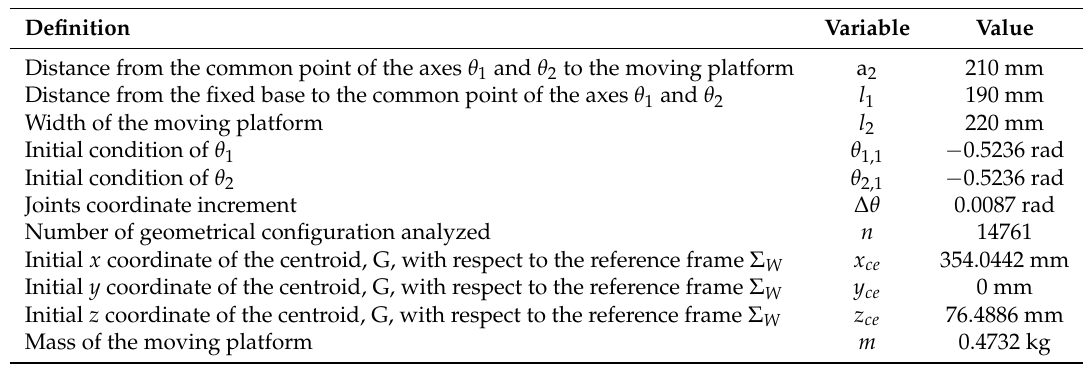
Table 2. Form-finding parameters.